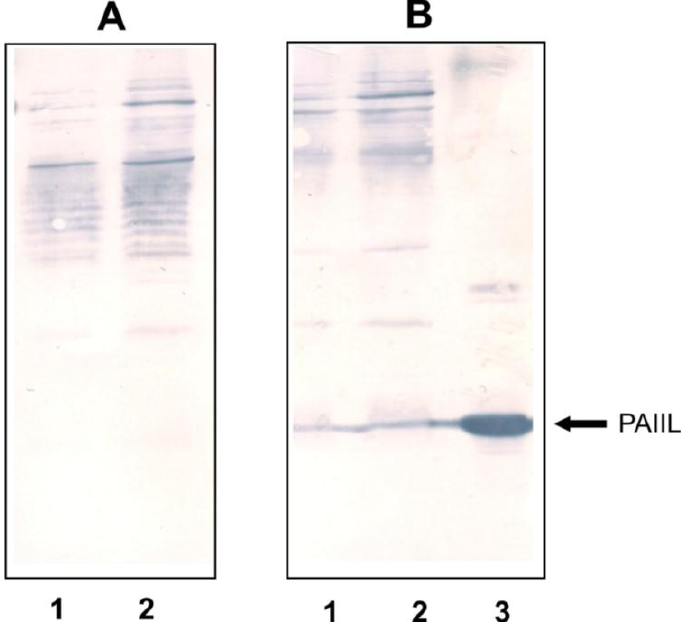
Figure 1. Western blot analysis of Pseudomonas aeruginosa lectin (PAIIL). Samples containing PAIIL, cell lysate of PA grown in rich medium PS (line 1 ) or in minimal mineral medium M9 (line 2 ) and recombinantly expressed PAIIL (line 3 ) were separated on reduced 10% SDS PAGE. Separated proteins were electrotransfered onto PVDF membranes and developed with pre-immune IgY (panel A ) and anti-PAIIL IgY (panel B ) at 30 µg/mL concentrations. The arrow marks the position of PAIIL protein